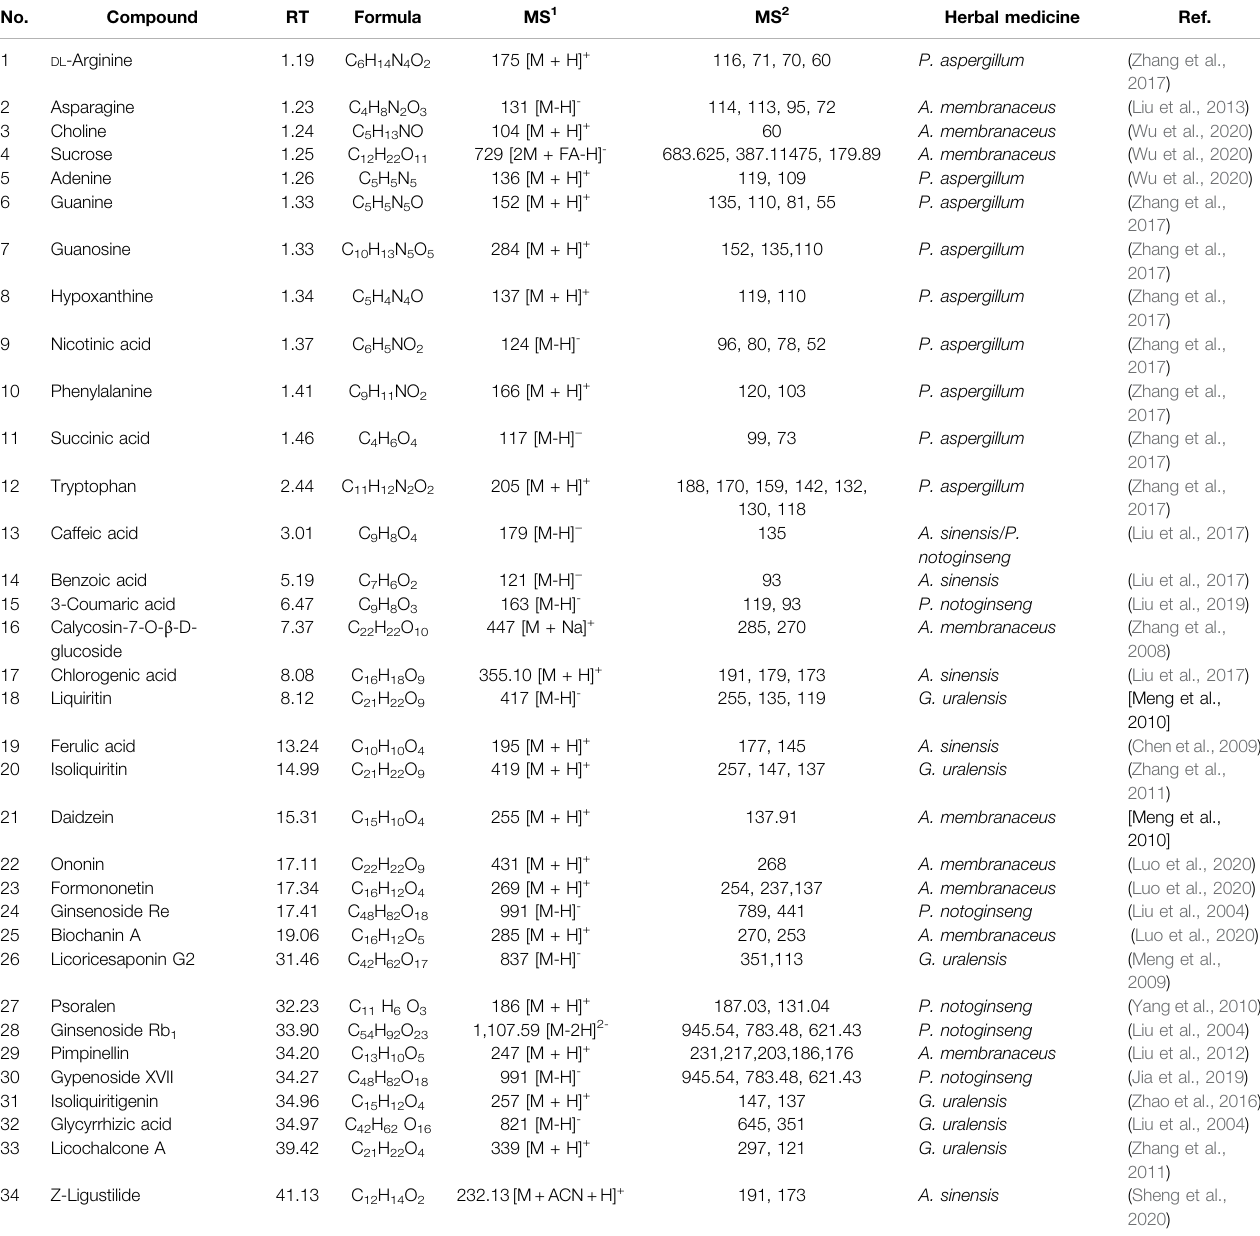
TABLE 1 | Precursor and product ions of constituents in the Buxue Tongluo Pill.